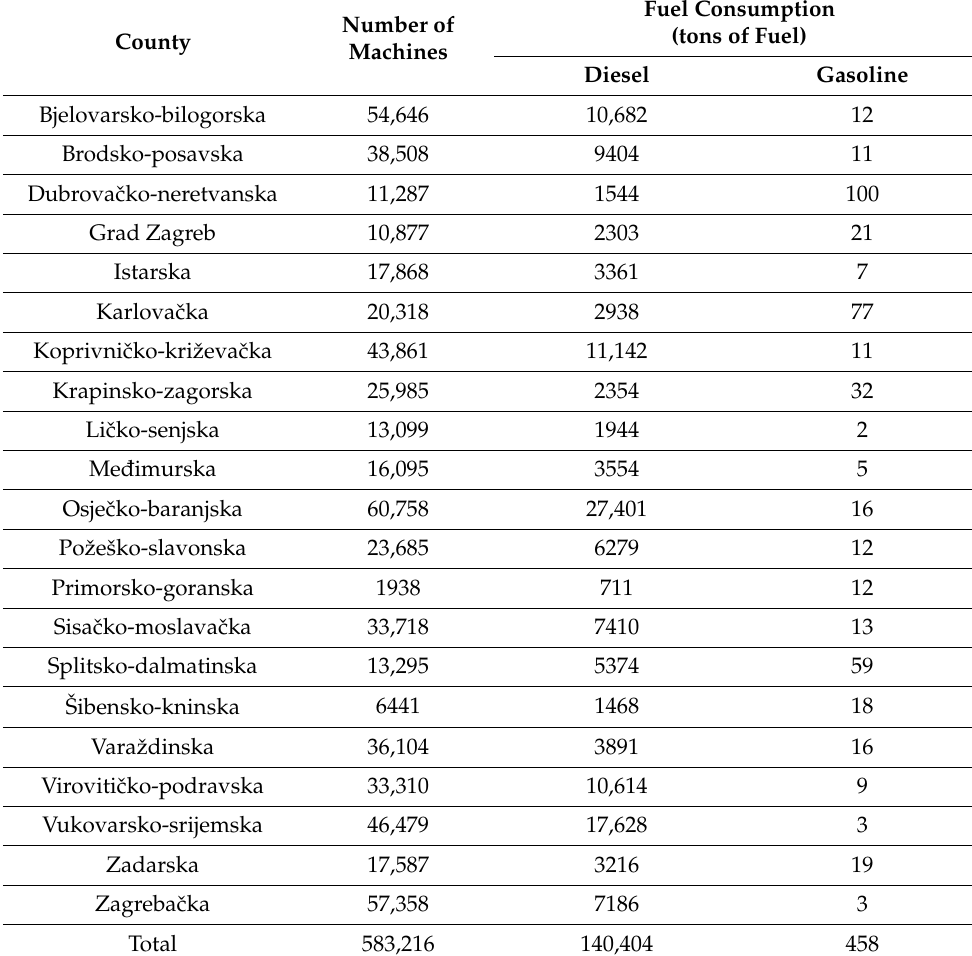
Table 3. The number of agricultural machines and diesel and gasoline fuel consumption per county. Fuel Consumption Number of (tons of Fuel) County Machines Diesel